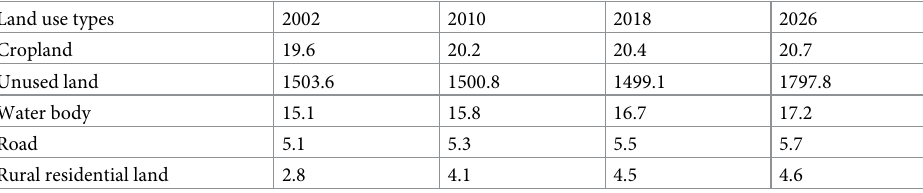
Table 5. Change in the land use composition of QPT from 2002 to 2026 (km 2